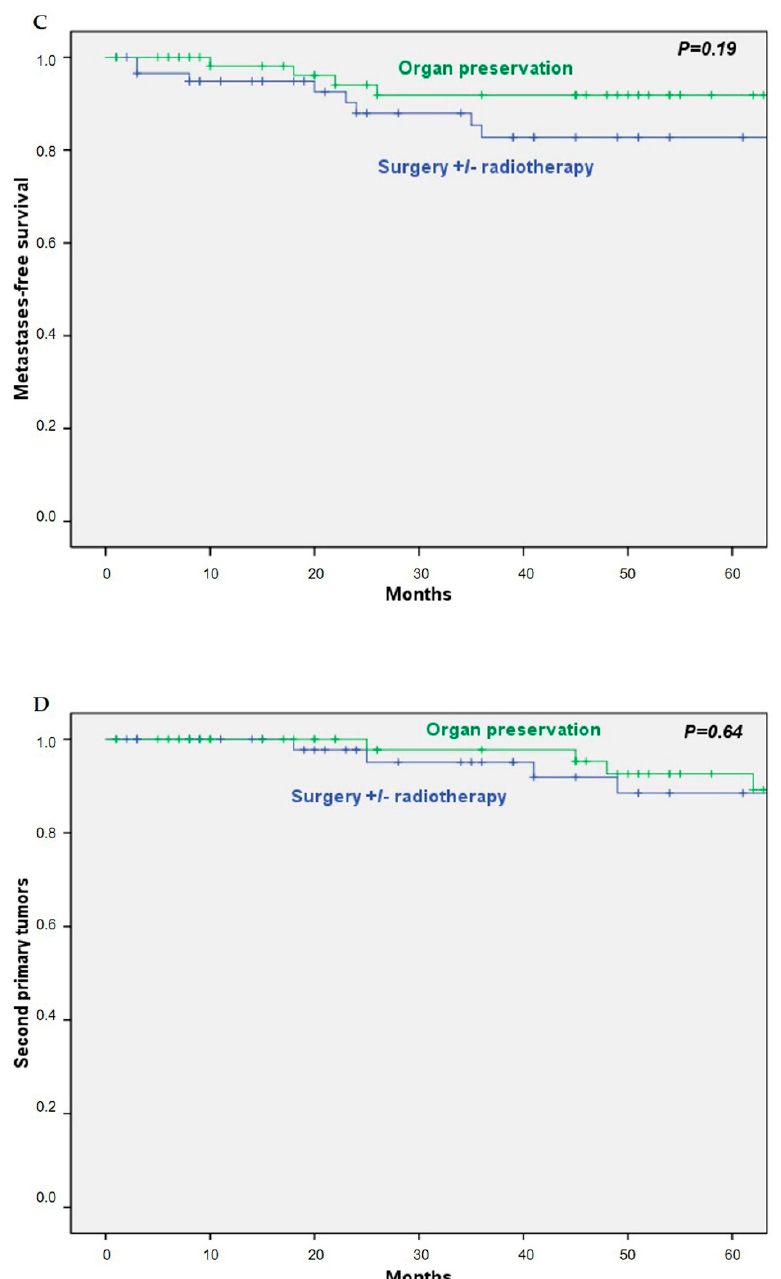
Figure 5. Kaplan-Meier curves for local control rate: ( A ) recurrence-free survival; ( B ) metastasis- free survival; ( C ) second primary tumors-free survival; ( D ) among patients treated with the organ preservation protocol or with up-front surgery.